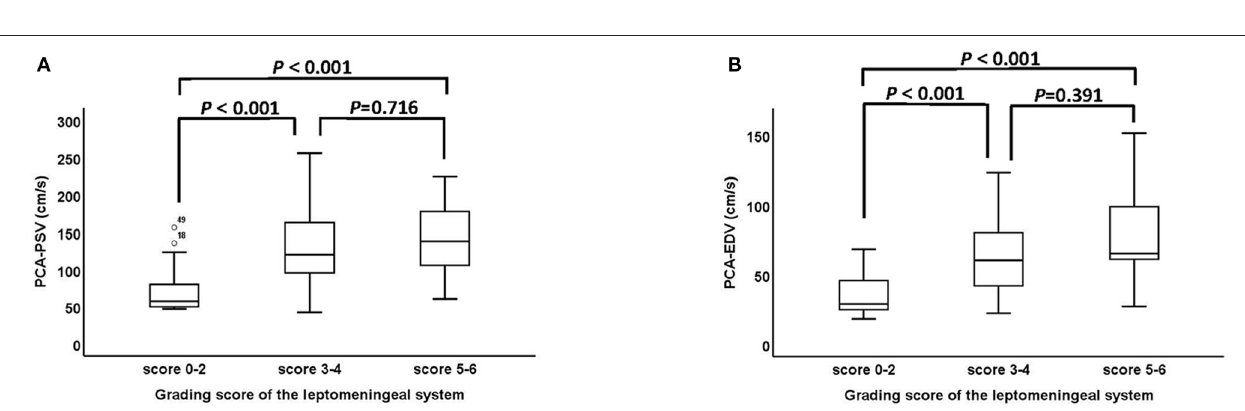
FIGURE 4 | The association between grading score of the leptomeningeal system from the PCA territory to the ACA and MCA territory and ultrasound parameters of the PCA. (A,B) The PSV and EDV of PCA between the score 0–2, score 3–4 and score 5–6 groups were statistically significant (PSV: P < 0001, EDV: P < 0.001). PCA, posterior cerebral artery; ACA, anterior cerebral artery; MCA, middle cerebral artery; PSV, peak systolic velocity; EDV, end diastolic